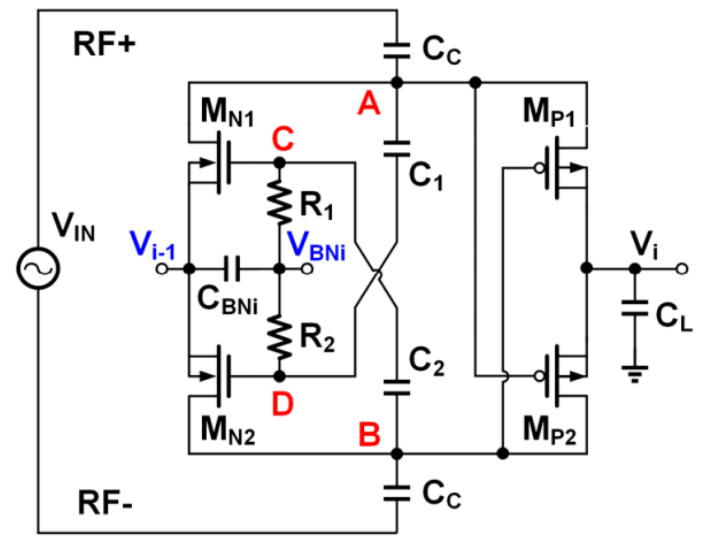
Figure 21. Cross Coupled rectifier with active bias tuning proposed in [50]. Reproduced with permission from X. Li, IEEE Journal of Solid-State Circuits; published by IEEE, 2020.